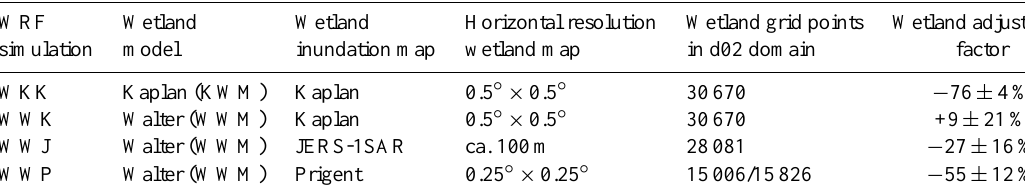
Table 3. Overview of the different WRF-GHG CH 4 simulations using different configurations for wetland models (Kaplan, 2002 or Walter et al., 2001a) and wetland inundation maps (Kaplan (Bergamaschi et al., 2007); JERS-1SAR (Hess et al., 2009); Prigent (Prigent et al., 2012)). The wetland inundation maps indicate the fraction of inundation per grid cell. All simulations use the Grell 3 convective scheme without the shallow convection options, the plumerise mechanism for biomass burning emissions, and initial and lateral boundary conditions for CH 4 from TM5. The number of wetland grid points shows the values for November and May for the Prigent wetland inundation map. Adjustment factors are chosen to match the mean atmospheric CH 4 observations for selected flights with a good representation of the atmospheric transport in the model in May 2009 (BARCA-B). Wetland Horizontal resolution Wetland grid points Wetland adjustment